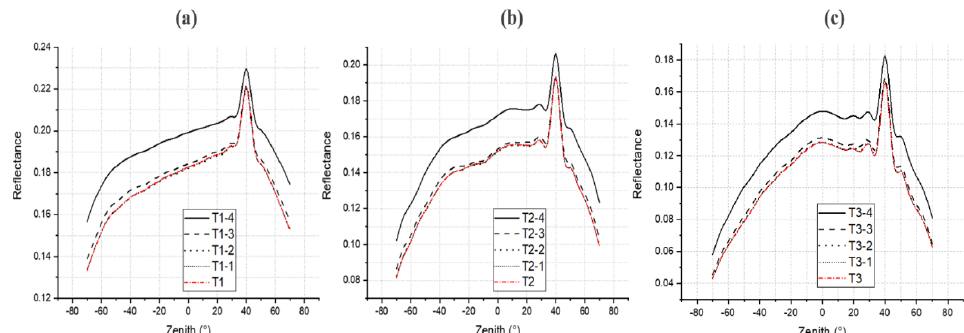
Figure 14. Reflectance at the wavelength 670 nm for different zenith angles, ( a ) first stage, ( b ) second stage, and ( c ) last stage.